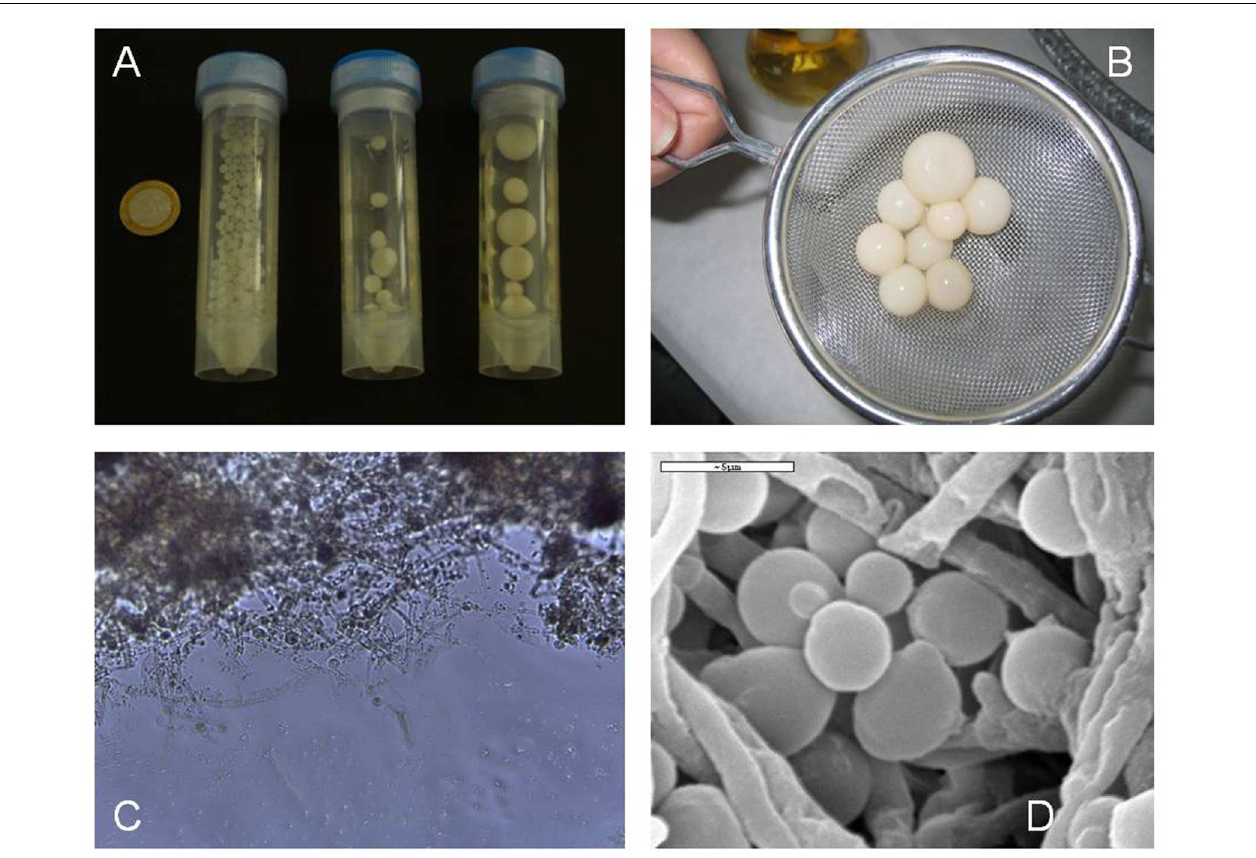
FIGURE 4 | Biocapsules of flor yeast. (A) Biocapsules of variable sizes obtained using an orbital shaker at 250, 200, and 150 rpm (left to right) for 7 days. (B) Biocapsules removed with a sterile strainer. (C) Biocapsule image under an optical microscope at 40 × magnification. (D) Scanning electron micrograph showing immobilized yeast cells entrapped in the hyphae of the filamentous fungus.